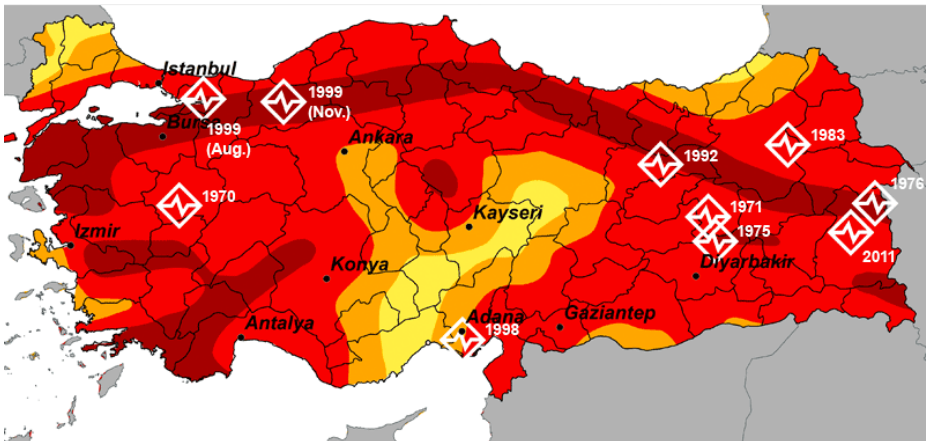
Figure 2. Map of seismic zones in Turkey (AFAD,